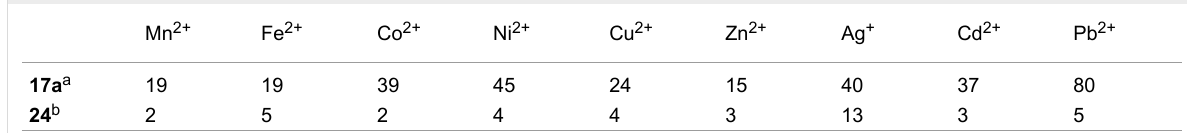
Table 4: Percentage extraction of transition- and heavy-metal picrates into CH 2 Cl 2 .